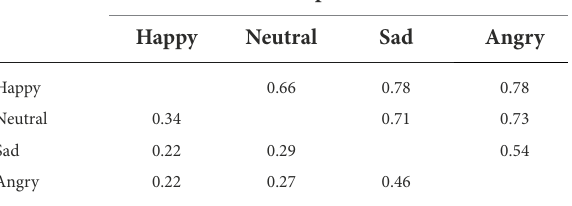
TABLE 1 Average ratio of chosen emotions in 500 ms presentation of Experiment 1.